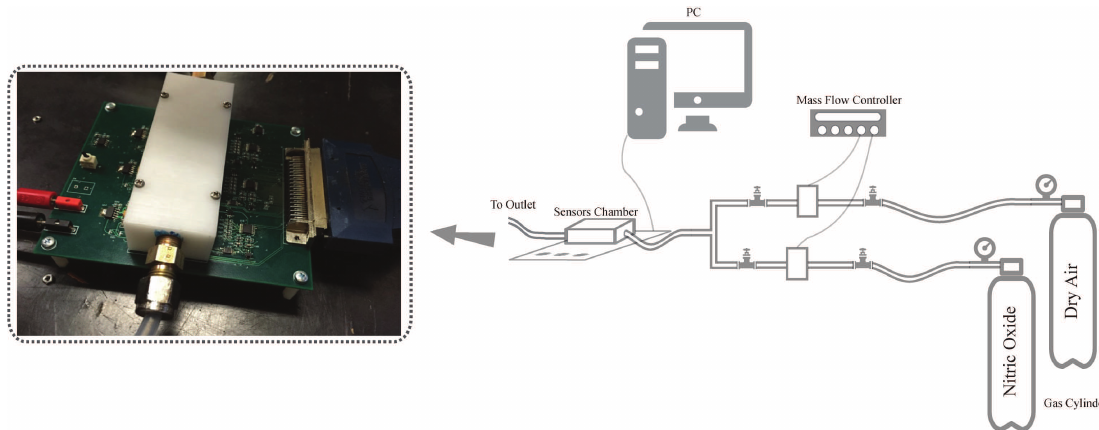
Figure 2. Experimental setup for gas delivery along with the data acquisition